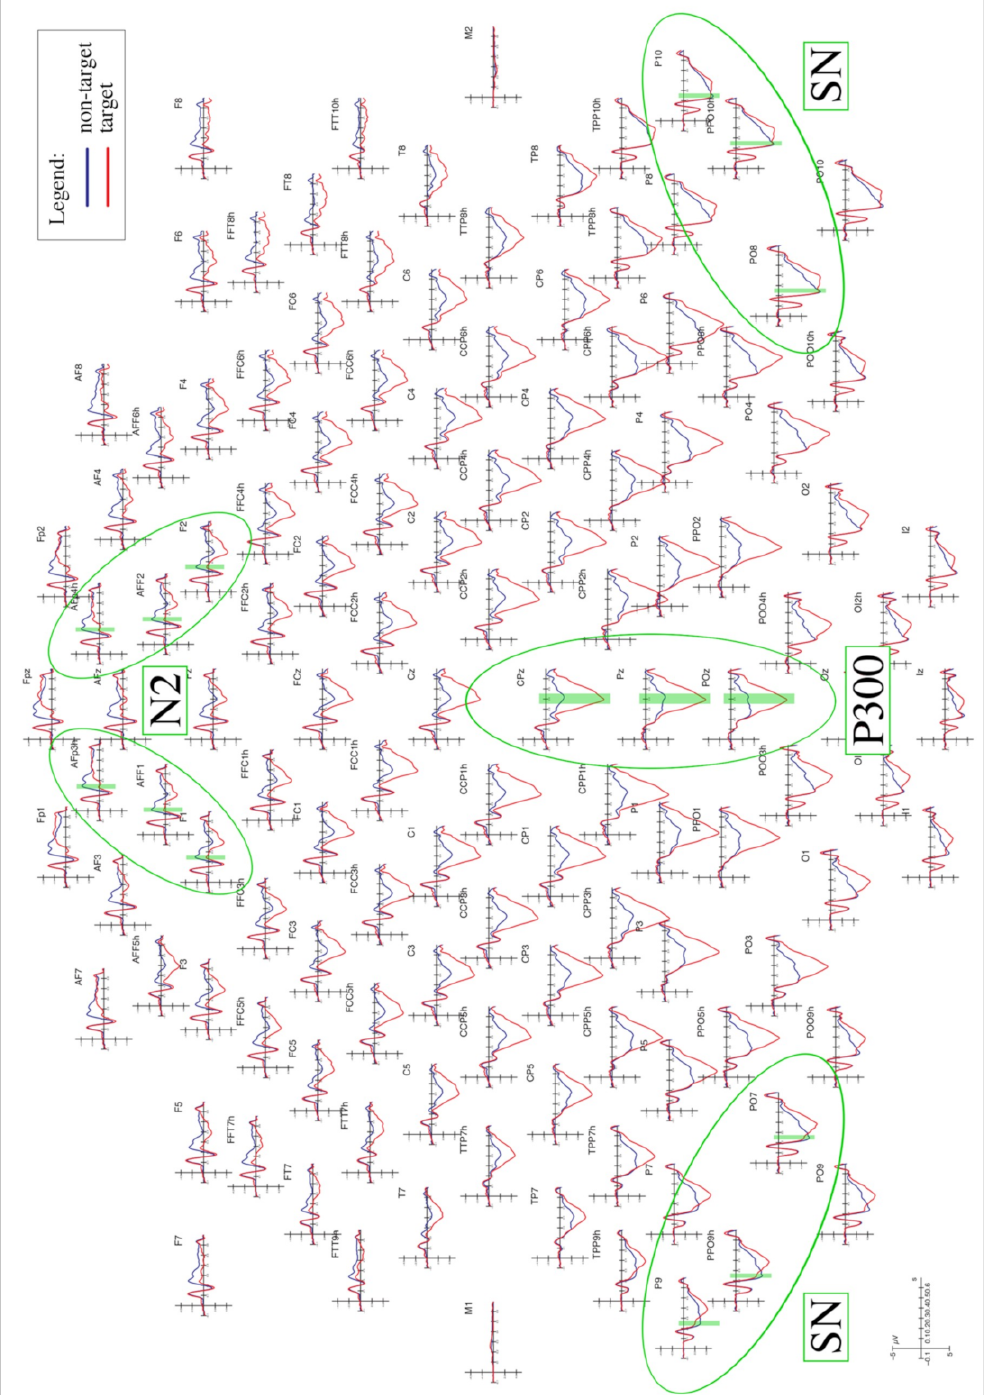
Figure 3. Grand average event-related potential (ERP) waveforms recorded over the scalp. Grand average waveforms (ERPs) recorded over the entire scalp (128 electrodes). The red lines represent the evoked response to target stimuli, while the blue lines represent the evoked response to non-target stimuli. The electrode sites where the three components of interest (N2, SN, and P300) reached the maximum peak are shown by the green circles. The time windows in which the N2 (225–265 ms), SN (240–280 ms), and P300 (350–450 ms) were analyzed are highlighted by the green